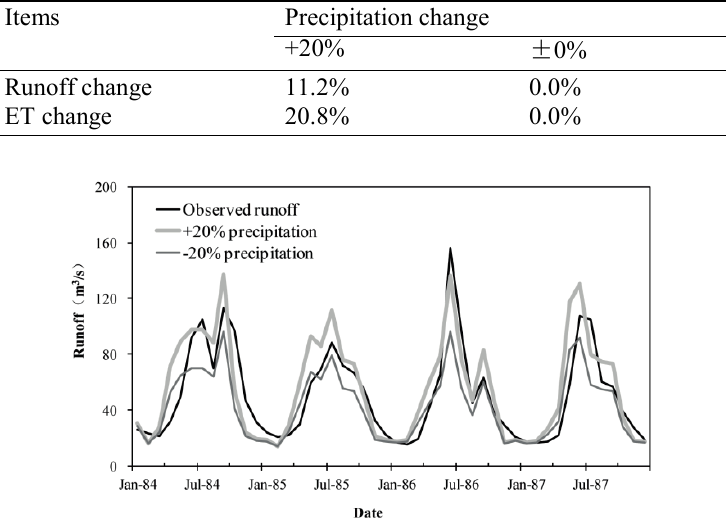
Fig. 5 Observed and simulated runoff